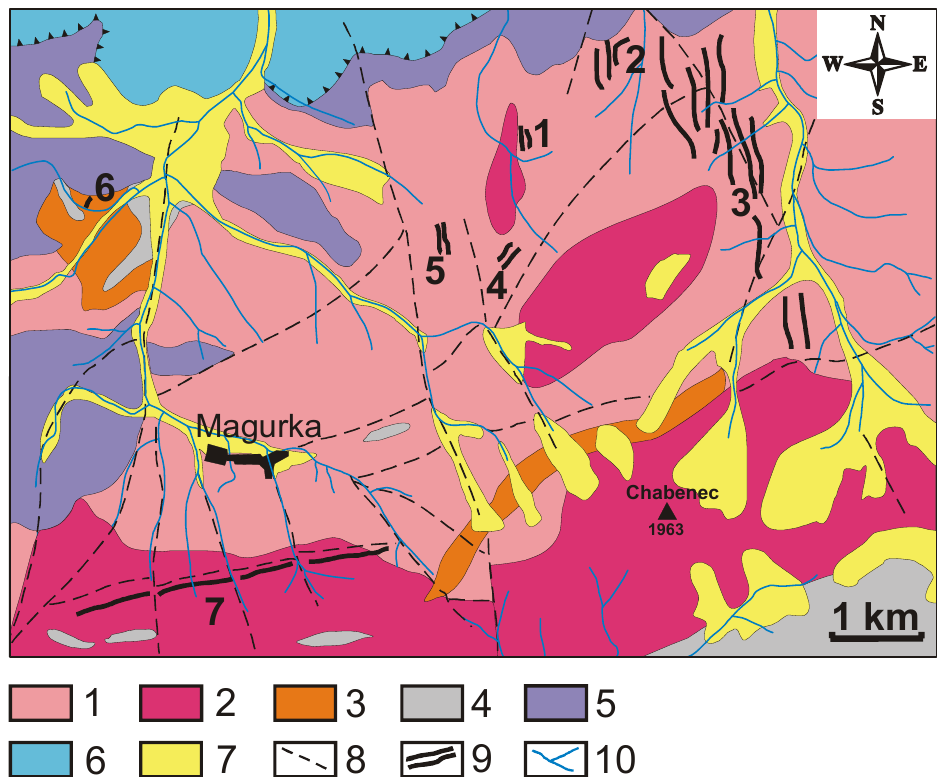
Figure 1. Geological map of the northern part of the central section of the N í zke Tatry Mts. (simplified after Biely [34]). Tatric Unit: 1.—granodiorites (Prašiv á type), 2.—tonalites to granodiorites ( ˇDumbier type), 3.—leucocratic granites, 4.—metamorphic rocks (phyllites, paragneisses), 5.—Tatric